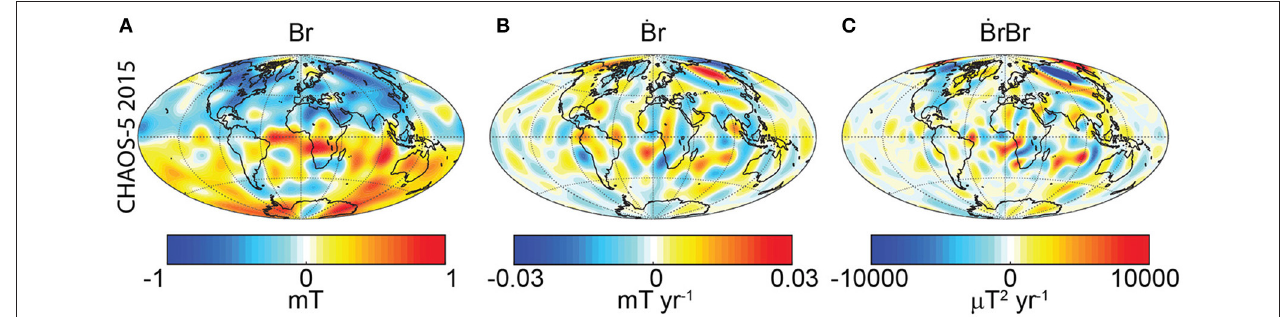
FIGURE 1 | (A) B r , (B) ˙ B r , and (C) B r ˙ B r , all for the geomagnetic field model CHAOS-5 in the year 2015 (Finlay et al., 2015).